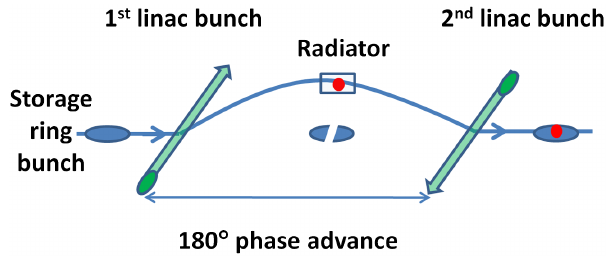
FIG. 7. Two linac bunches form a local bump for the kicked electrons in the storage ring.